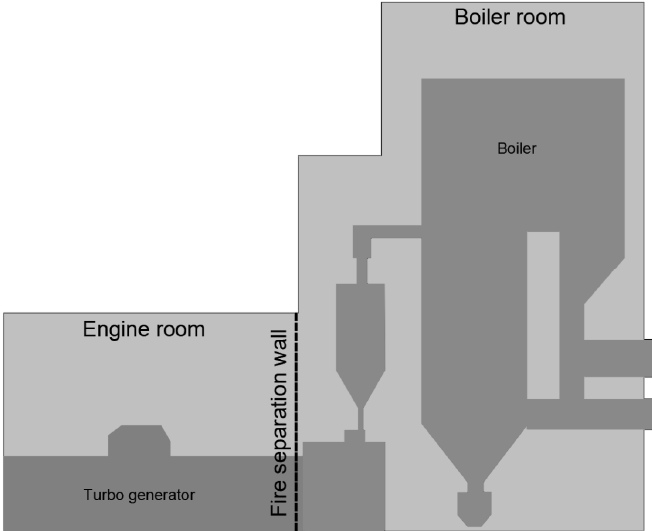
Figure 1. A scheme of the power plant building.